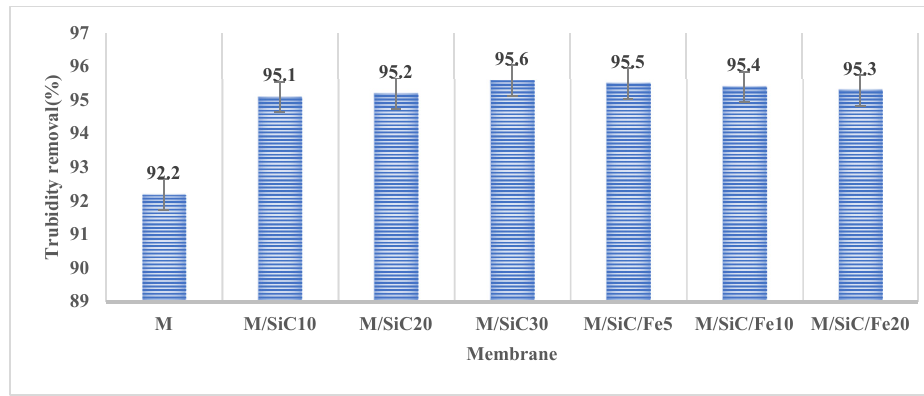
Figure 11. Turbidity removal (%) by the manufactured microfiltration membranes.